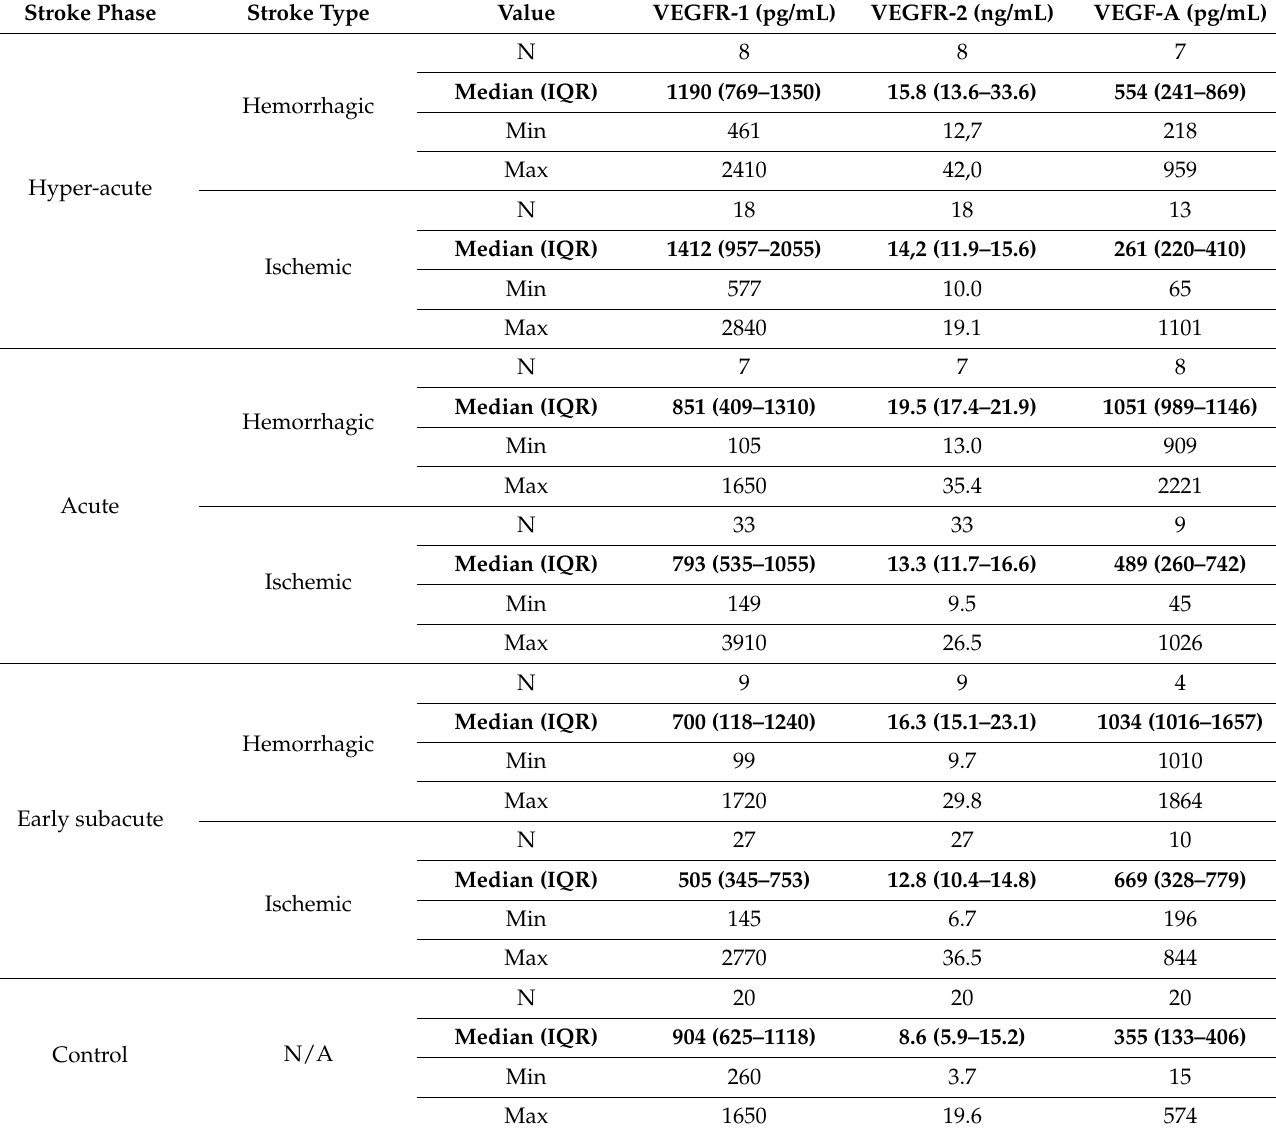
Table 2. Values of VEGFR-1, VEGFR-2, and VEGF-A in patient groups (according to stroke type and